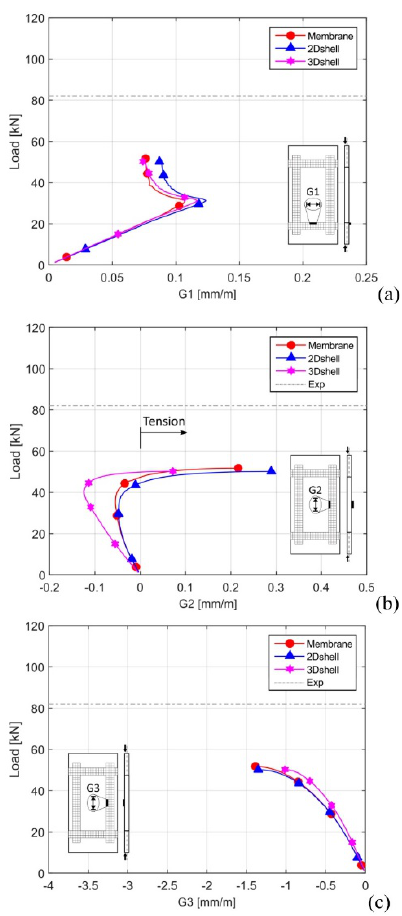
Figure 9. Load-strain behavior of strengthened